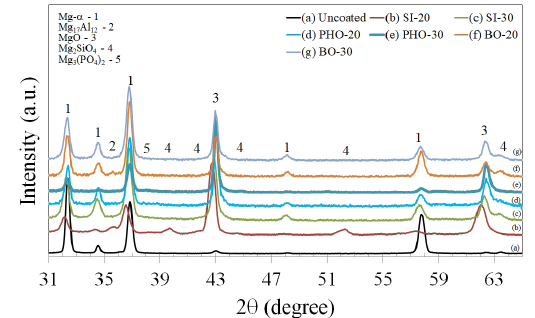
Figure 3. XRD patterns of the uncoated and anodized AZ61